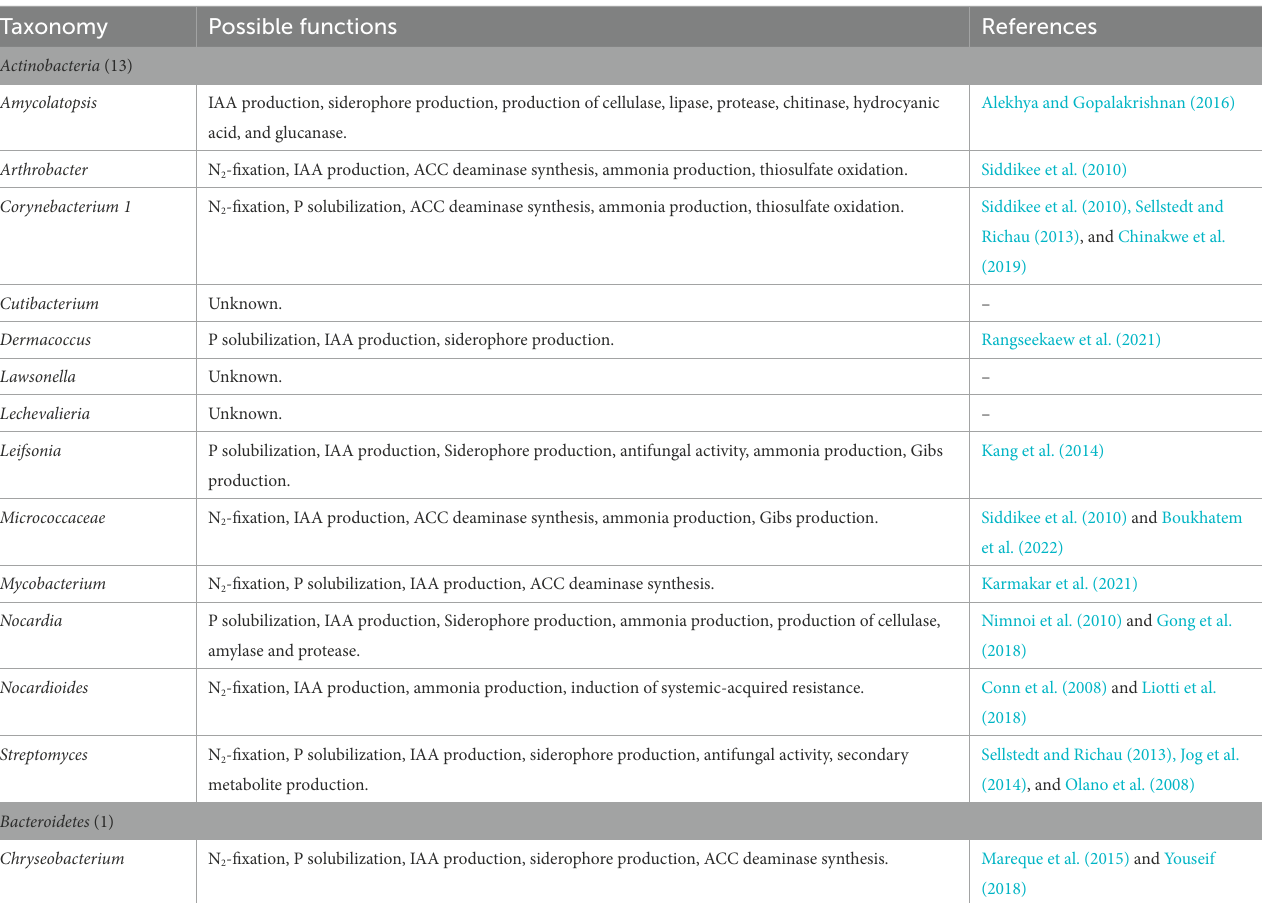
TABLE 4A The 27 taxa comprising core bacteria of the water yam ( Dioscorea alata L.) bacterial microbiota and their possible plant growth-promoting